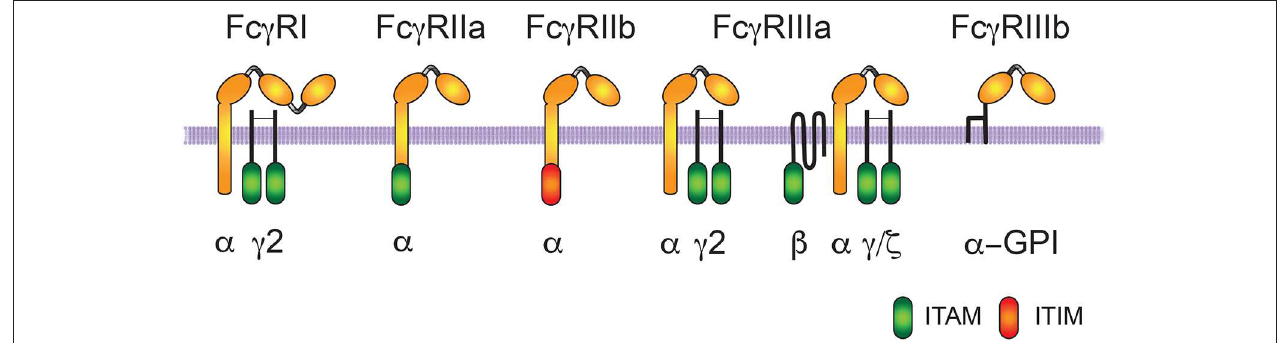
FIGURE 1 | Human Fc γ receptors. The human receptors for the Fc portion of immunoglobulin G (IgG) molecules are classified in three groups Fc γ RI, Fc γ RII, and Fc γ RIII. The IgG binding α -subunit in the high affinity Fc γ RI, possesses three immunoglobulin (Ig)-like extracellular domains. The α -subunit in the other low-affinity receptors presents only two Ig-like domains. Activating receptors contain an ITAM (immunoreceptor tyrosine-based activation motif) sequence within the α subunit (for Fc γ RIIa) or within the accessory γ and ζ chains (for Fc γ RI and Fc γ RIIIa). Fc γ RIIIa has a homodimer of γ chains in macrophages, natural killer (NK) cells, and dendritic cells, whereas it has a heterodimer of γ / ζ chains and an extra β chain in basophils and mast cells. Fc γ RIIIb is also an activating receptor, which is bound to the cell membrane via a glycosylphosphatidylinositol (GPI) anchor. In contrast, Fc γ RIIb is an inhibitory receptor containing an ITIM (immunoreceptor tyrosine-based inhibition motif) sequence.